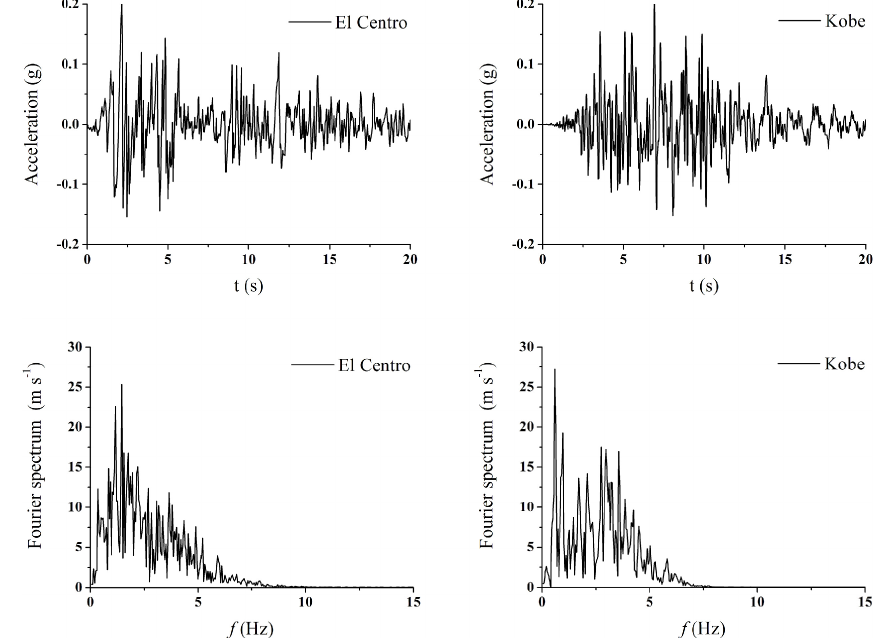
Figure 2. Acceleration time history curve of seismic waves. Table 2. Surface peak ground acceleration PGA surface of monitoring point A (unit: g ). Base